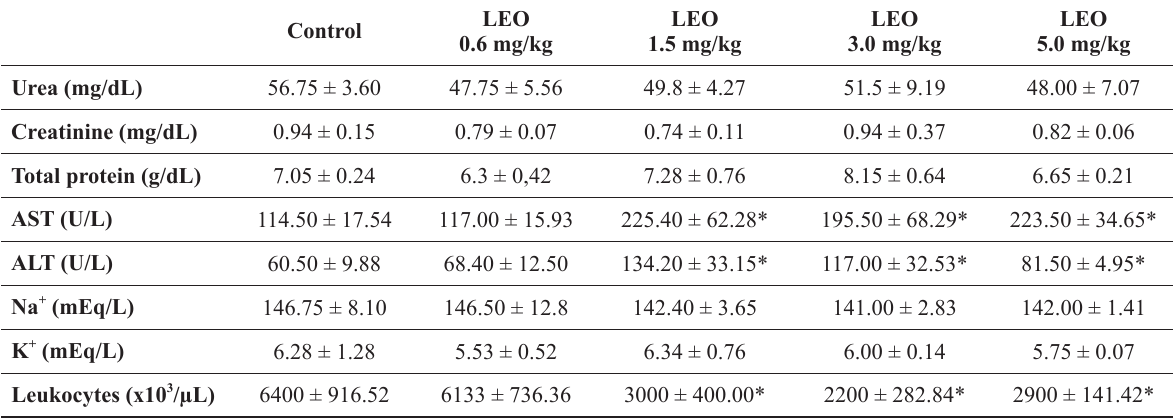
Effects of the Lavandula augustifolia essential oil (LEO) administered orally on serum biochemical and hematological parameters in female Wistar rats.